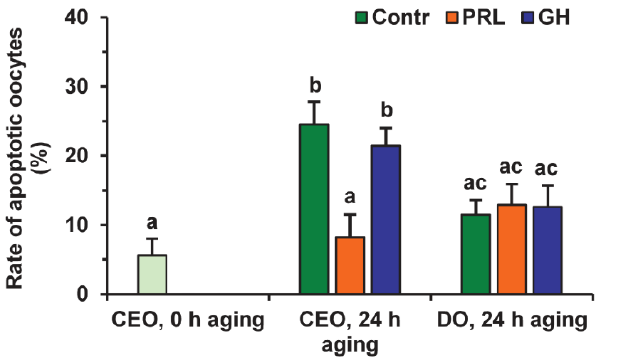
Figure 7. Effects of PRL (50 ng/mL) and GH (10 ng/mL) on oocyte apoptosis during the 24 h aging of bovine CEOs and DOs. Data represent means ± SEM of 4 replicates using 75–88 oocytes per treatment. Means marked with different letters differ significantly (at least p < 0.05).